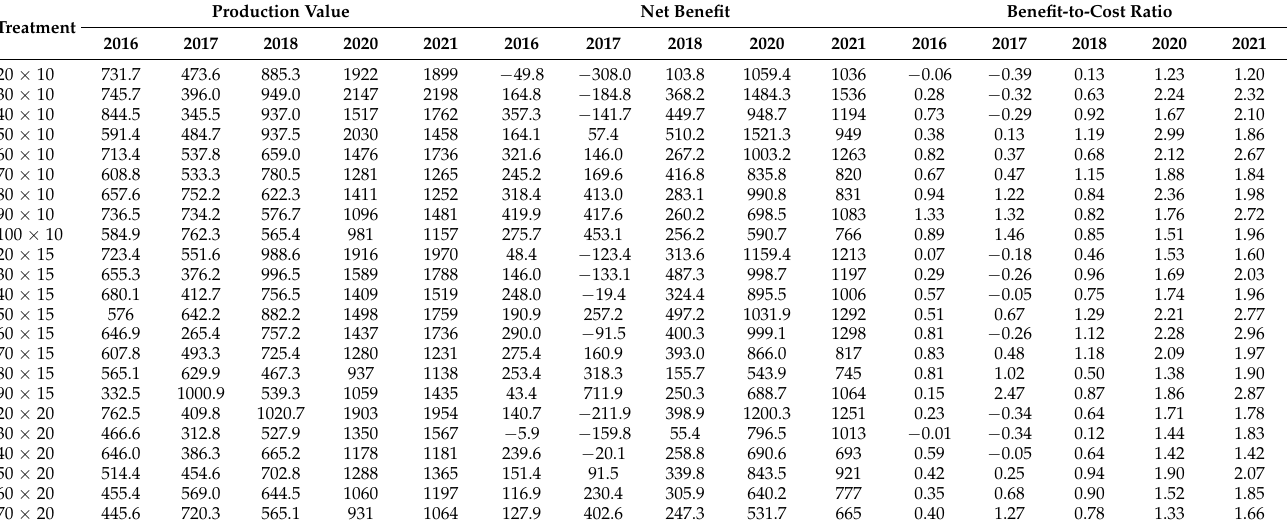
Table 8. Production value (USD), net benefit (USD), and benefit-to-cost ratio per hectare of spacing treatments from grain and haulm sale for each year (2016, 2017, 2018, 2020,